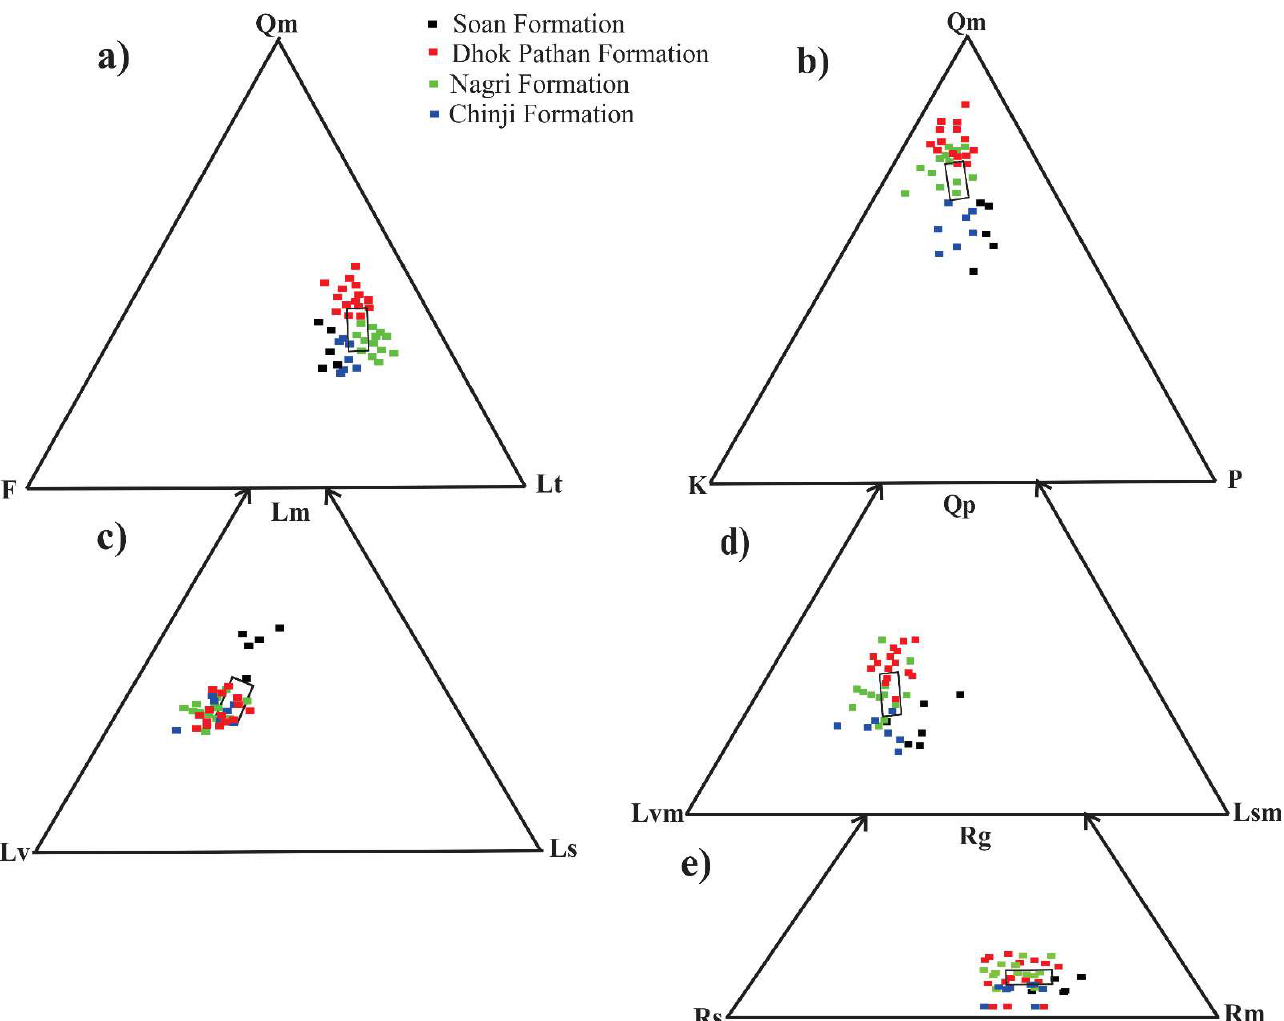
Figure 9. QmFLt ( a ), QmPK ( b ), LmLvLs ( c ), QpLvmLsm ( d ) and RgRsRm ( e ) ternary plots for the Siwalik Group. Polygons are one standard deviation on either side of the mean.The modal composition data plotted on the diamond diagram of Basu, et al. [53] indicate the plutonic and metamorphic provenances of middle to upper rank for the sandstone of Siwalik Group (Table 2; Figure 10a;). The bivariant log–log plot (Qp/(F + L)) against Q/(F + L) reveals that the Chinji and Soan Formations' sandstone are plotted in semi-arid whereas, the sandstone of Nagri and Dhok Pathan Formations are plotted in the semi-humid field (Figure 10b). The weathering index diagrams indicate the majority of sandstone plots fall into the field of wi = 0 (Figure 10c) [54,55]. The paleoclimatic condition of the Siwalik Group is interpreted as arid to semi-humid by plotting QFL data on the ternary diagram (Figure 10d) [56].